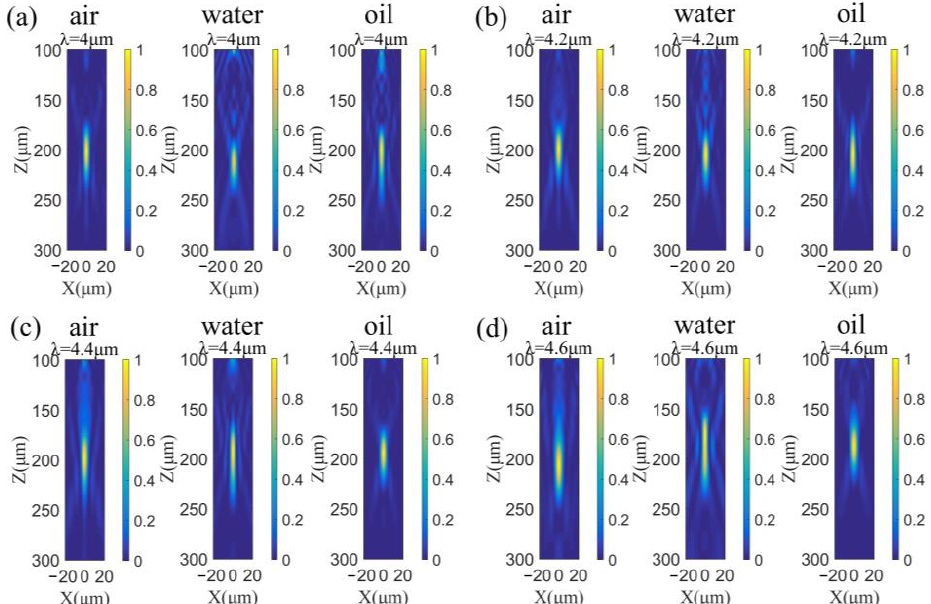
Figure 6. Focusing performance of the designed metalens at wavelengths of 4.0 μm ( a ), 4.2 μm ( b ), 4.4 μm ( c ) and 4.6 μm ( d ), when the metalens is under the environment of water or oil.